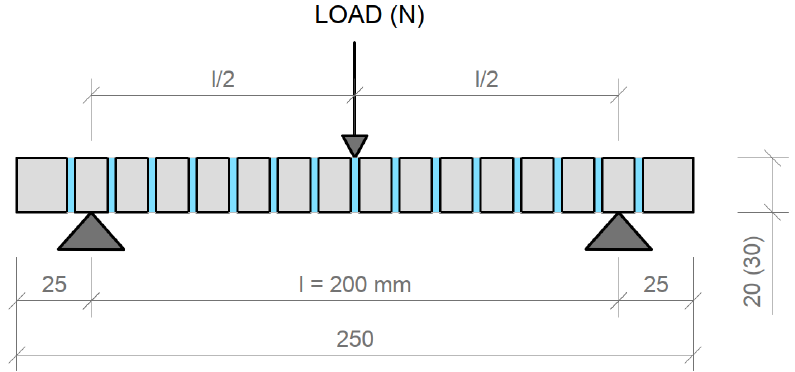
Figure 39. Tensile flexural strength 3-point bending test diagram for LTC slabs.